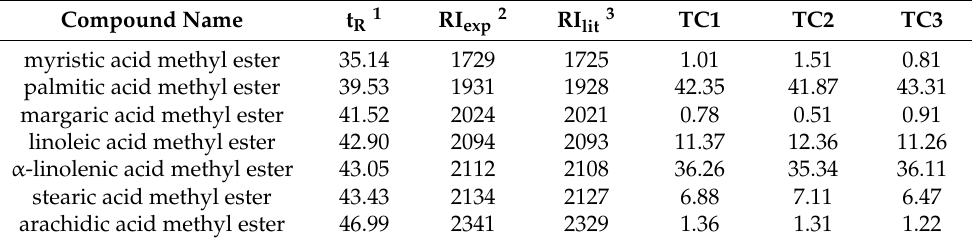
Table 1. Results of fatty acid analysis. Relative peak areas were calculated from identified compounds and are given in percent.